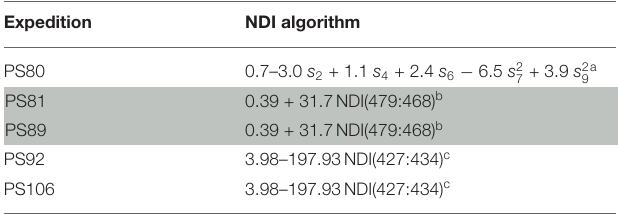
TABLE 2 | Normalized Difference Indices and Empirical Orthogonal Functions algorithms used to retrieve in-ice chl a for the different